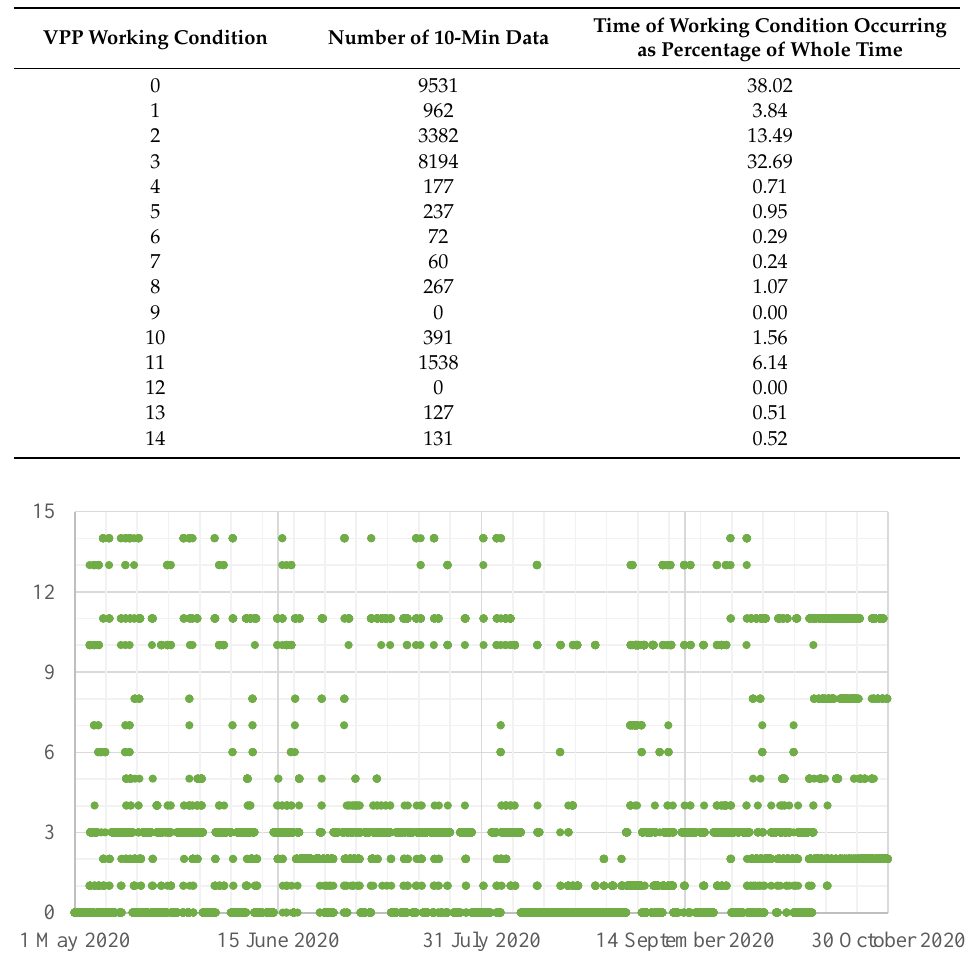
Table 4. Duration of different working conditions.